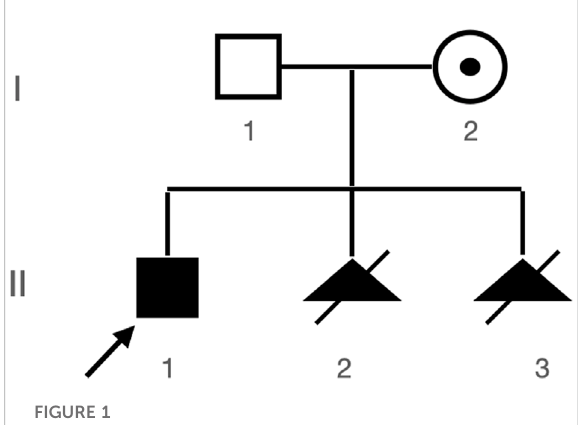
FIGURE 1 Patient ’ s pedigree. Proband (II-1) and two subsequent aborted products II-2 and II-3, both with abnormal genitalia seen during prenatal ultrasound and both with 46, XY karyotypes (karyotypes not shown).